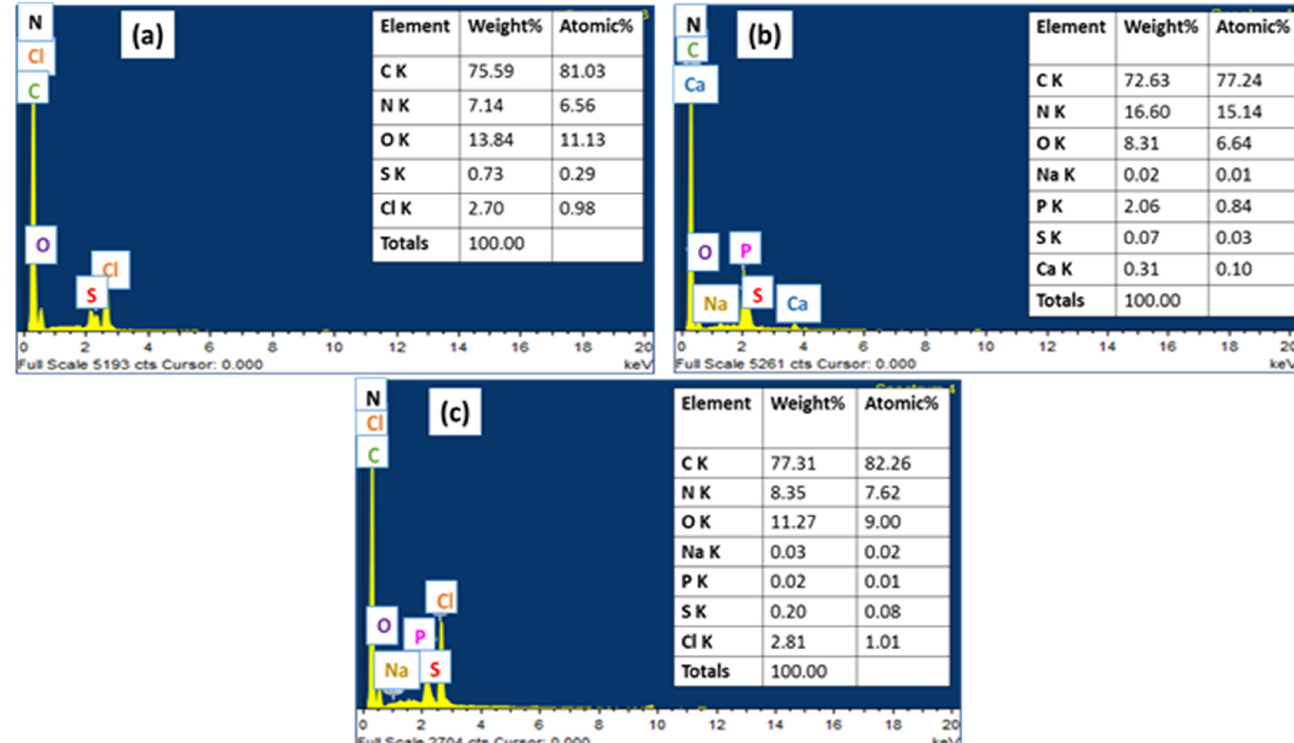
Figure 3. EDX spectra of ( a ) PIN, ( b ) AC, and ( c ) AC@PIN-3 composite.